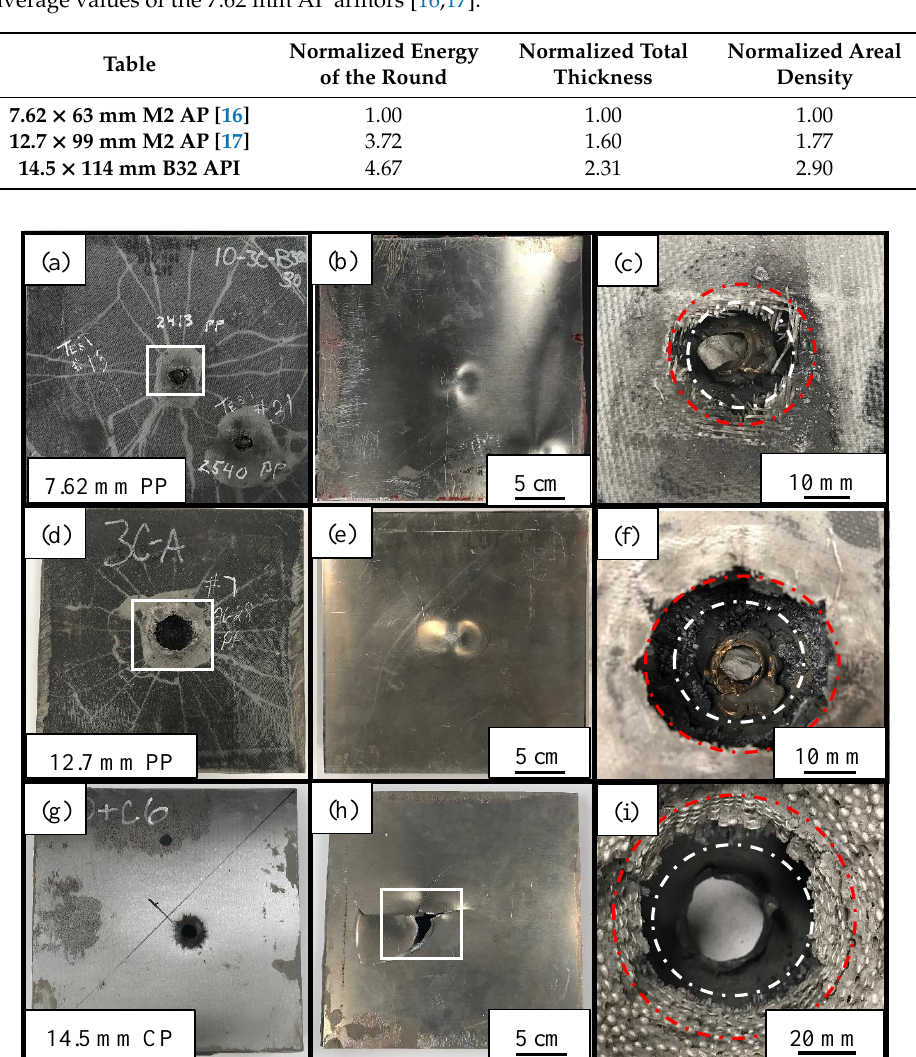
Figure 10. Digital images of the front and back of the layered SS-CMF armors, highlighting the impact region after testing against a ( a – c ) 7.62 mm M2 AP, ( d – f ) 12.7 mm M2 AP, and ( g – i ) 14.5 mm B32 API.